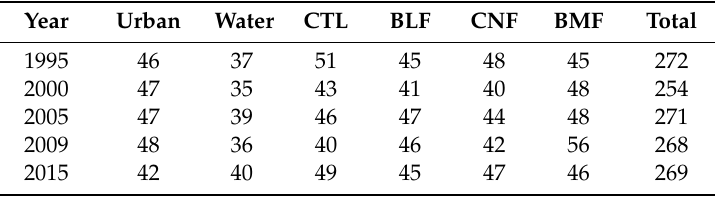
Table 2. Number of verification plots in di ff erent